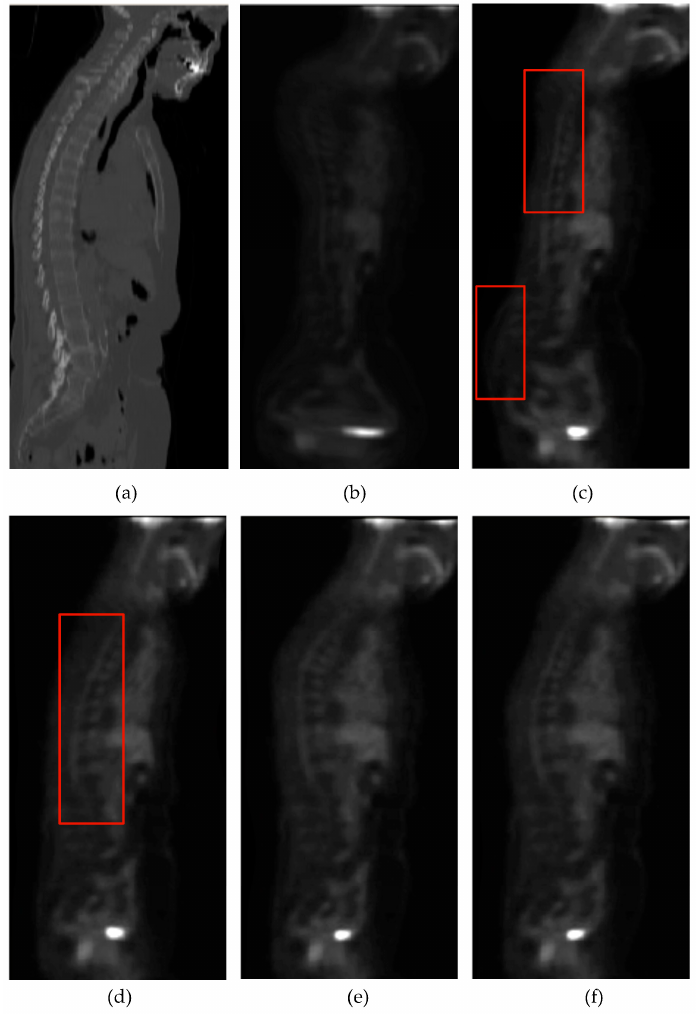
Figure 11. Registration results of all evaluated methods operating on the 3D CT–PET images. ( a ) CT (reference image); ( b ) PET (float image); ( c ) ESSD; ( d ) MIND; ( e ) HLCSO; and, ( f ) FMIND.